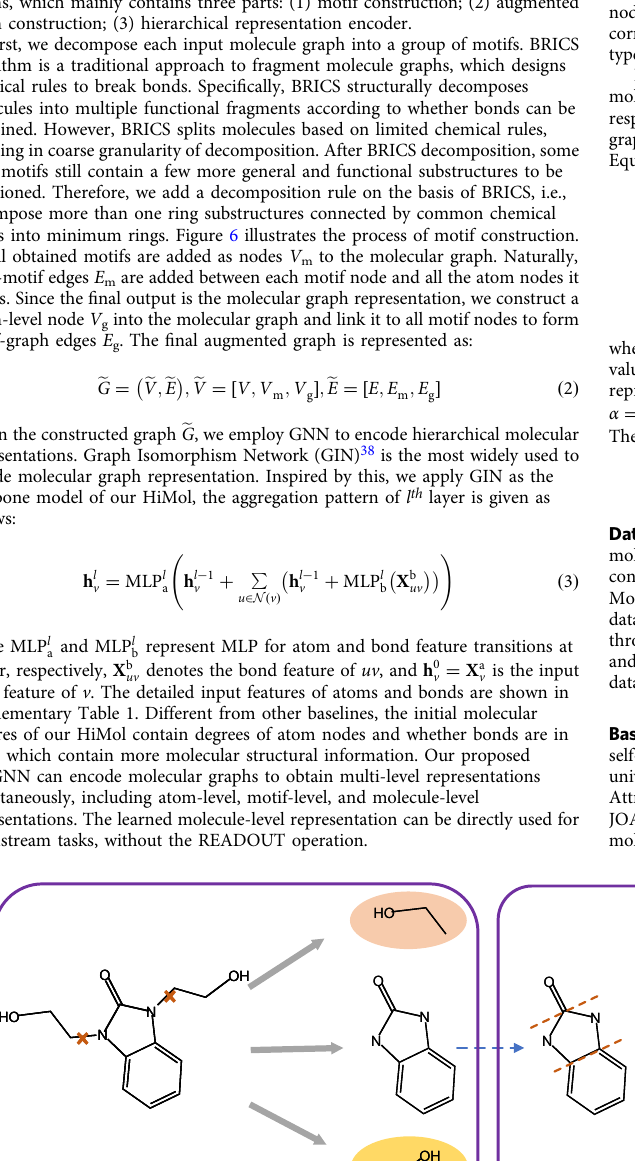
Fig. 6 Overview of motif construction. The construction process consists of three steps: (1) A given molecule graph is decomposed according to BRICS. (2) The molecule is further decomposed through our additional rule. (3) Decomposed motifs are constructed as motif-level